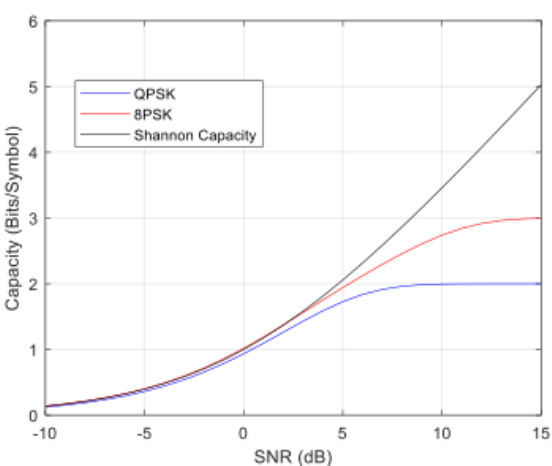
Figure 2. Approximation of Constrained Capacity for QPSK and 8 -PSK and Shannon